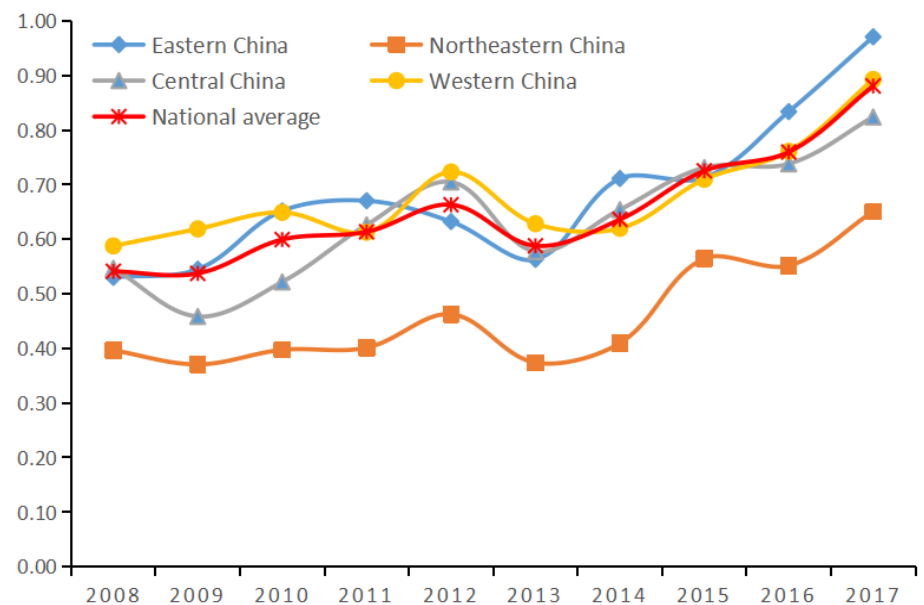
Figure 1. Change in the average value of efficiency in the first stage from 2008 to 2017.